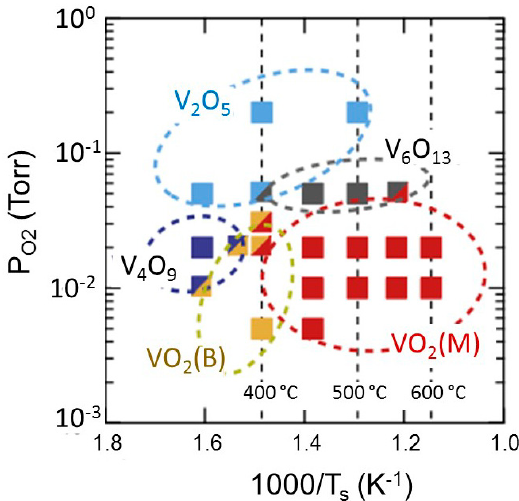
Figure 12. P O vs. 1000 / T s phase diagram for films of vanadium oxides laser-pulse deposited on silicon Figure 12. P O ₂ vs. 1000/ T s phase diagram for films of vanadium oxides laser-pulse deposited on 2 substrates. (Reproduced with permission from [213]. Copyright 2015 AIP silicon substrates. (Reproduced with permission from [213]. Copyright 2015 AIP Publishing).